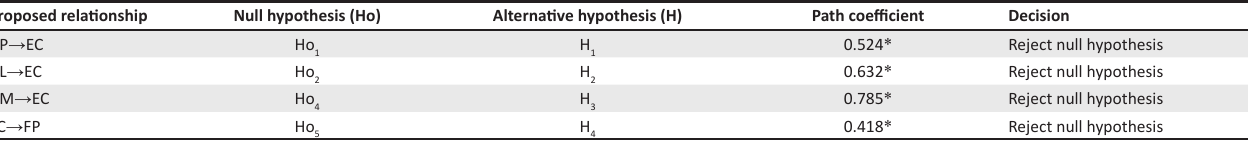
TABLE 5: Structural equation modelling results. Proposed relationship Null hypothesis (Ho) Alternative hypothesis